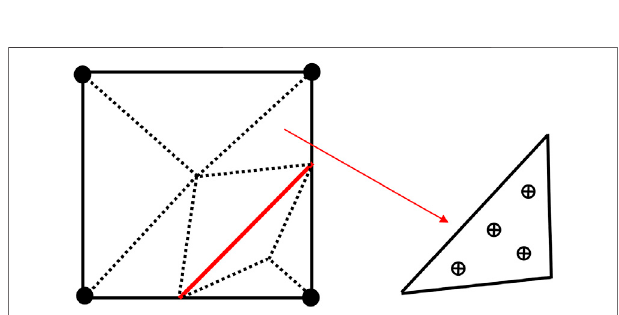
FIGURE 3 | Diagram of subcell integration of element cut by discontinuous interface (with a 2-D quadrilateral element as an example).